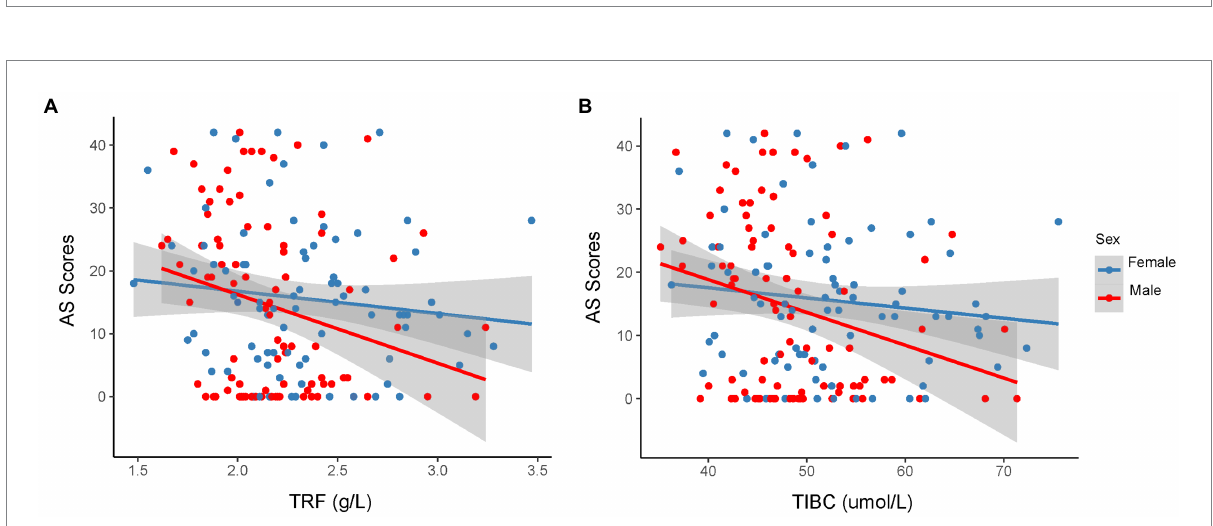
FIGURE 2 Correlation between AS scores and serum TRF (A) or TIBC (B) in the different sexual patients with PD. Spearman correlation showed a weak relationship between AS score and serum TRF concentration ( r = − 0.27, p = 0.010), TIBC ( r = − 0.259, p = 0.014) in male participants with PD. However, there were no significant associations between AS score and the level of TRF ( r = − 0.109, p = 0.333) or TIBC ( r = − 0.116, p = 0.302) for female patients. AS, Apathy Scale; PD, Parkinson’s disease; TIBC, total iron binding capacity; TRF,